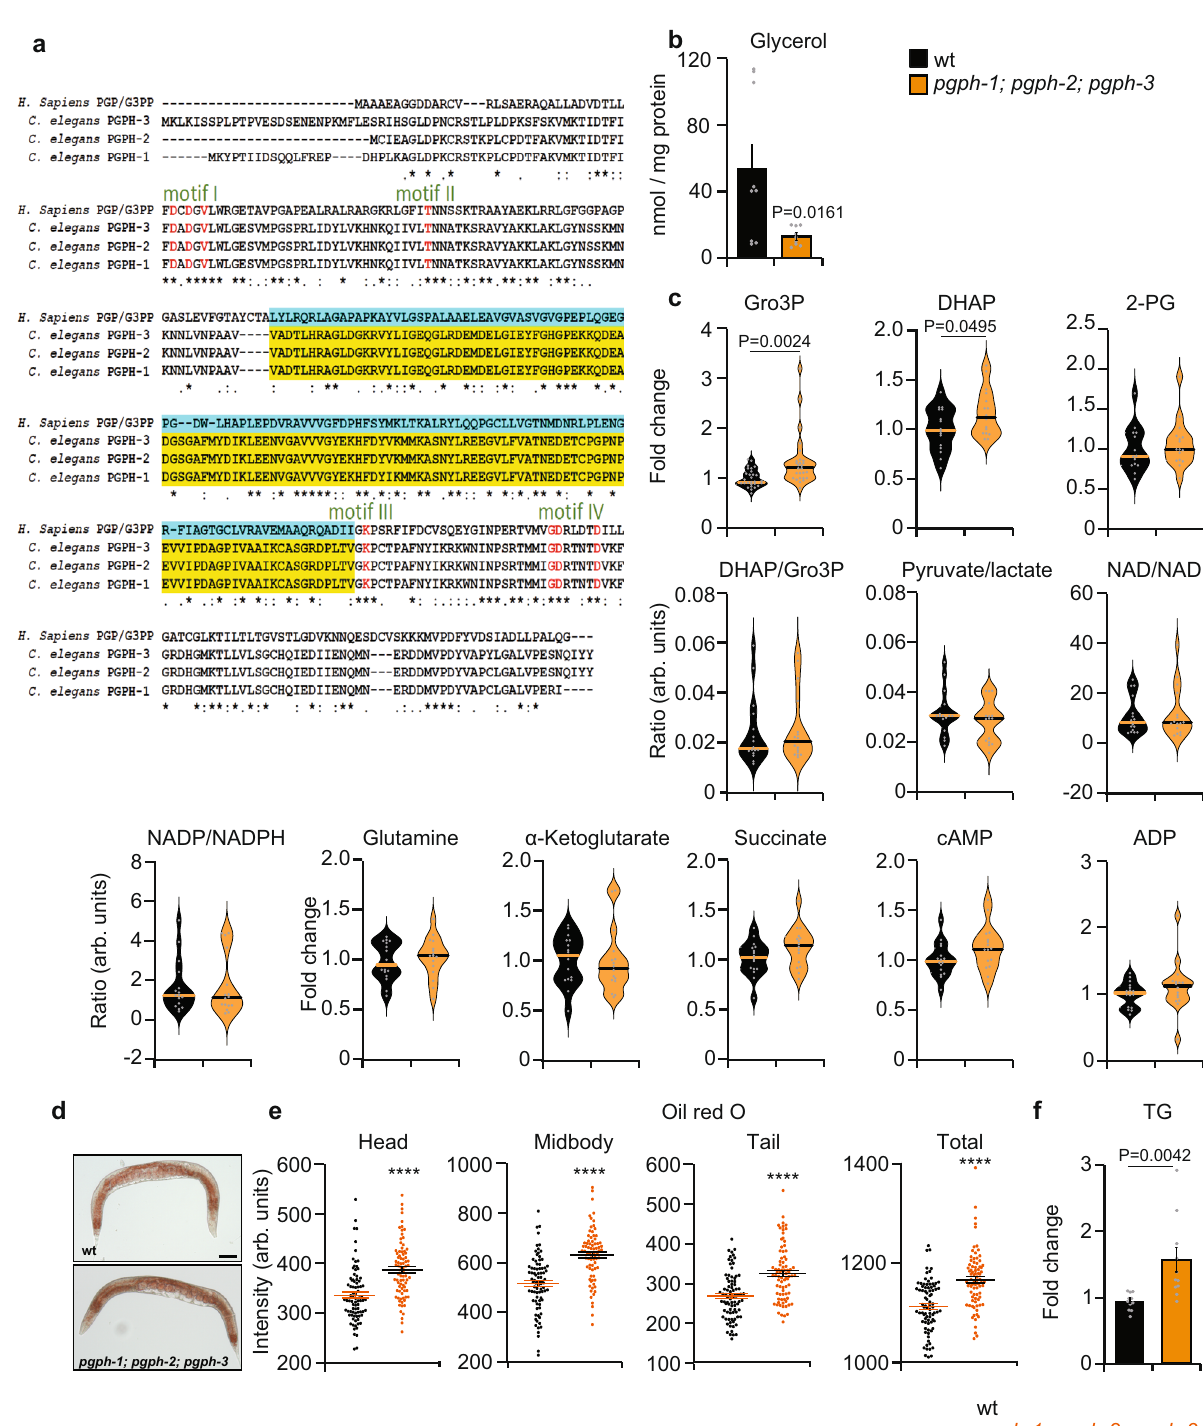
Fig. 1 C. elegans harbors three homologs of mammalian PGP/G3PP with glycerol-3-phosphate phosphatase function. a Sequence alignment of PGP/ G3PP was performed using Clustal Omega. Regulatory motifs are indicated and the cap domain is highlighted. b Glycerol content in wild-type (WT) and pgph-1; pgph-2 ; pgph-3 synchronized L4/young adult animals grown on NGM plates. Data represent mean ± SEM, three biological replicates, and three independent experiments. c Violin plots of relative metabolite levels and ratios of some metabolites in WT and pgph-1; pgph-2 ; pgph-3 synchronized L4/ young adult animals grown on NGM plates. Lines in violin plots denote the median of the analyzed groups and gray circles indicate individual data points (four biological replicates per group per independent experiment and four independent repeats). d , e Oil red O staining and quanti fi cation in WT and pgph- 1; pgph-2 ; pgph-3 mutant 1-day adult animals. Data represent mean ± SEM from three independent experiments (WT, n = 83 and pgph-1; pgph-2; pgph-3 , n = 81). Scale bars represent 50 µ m. f Triglyceride levels in WT and pgph-1; pgph-2; pgph-3 1-day adult synchronized animals. Data represent mean ± SEM, three biological replicates per group per independent repeat, and three independent experiments. In all fi gures, **** P < 0.0001 and P -values were obtained by student ’ s two-tailed t -test. Data are provided as a Source Data fi